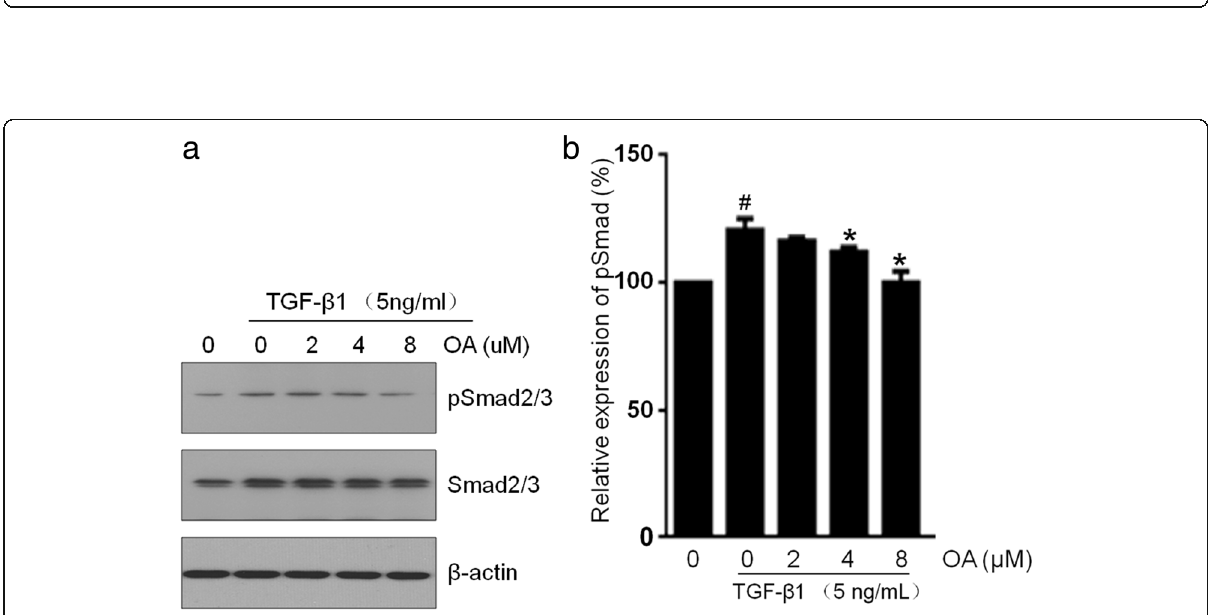
Fig. 5 Effects of OA on the expression of pSmad2/3 in NRK-52E cells. The cells were incubated with 5 ng/mL of TGF- β 1 for 48 h with different concentrations of OA (0, 2, 4, 8 μ M). a The expression level of Smad2/3 and pSmad2/3 was determined by Western blotting. b The pSmad2/3 was quantitatively analyzed with Image J software. The data showing mean ± SD. # P < 0.05 vs. 0 ng/mL TGF- β 1. * P < 0.05 vs. 0 μ M OA in the presence of 5 ng/mL TGF- β